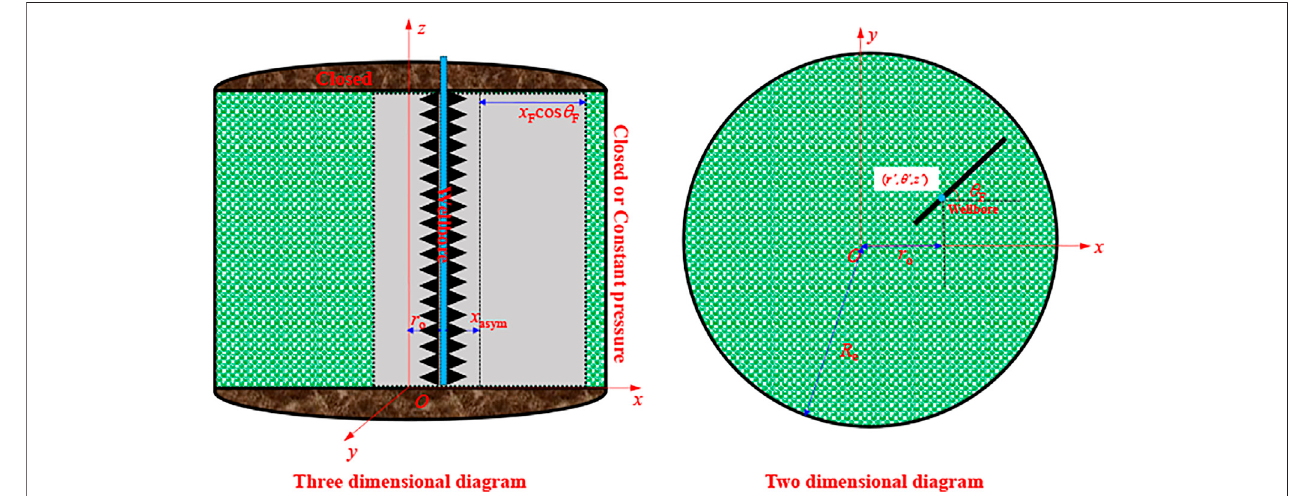
FIGURE 1 | Schematic diagram of off-centered fractured well with asymmetric fracture.